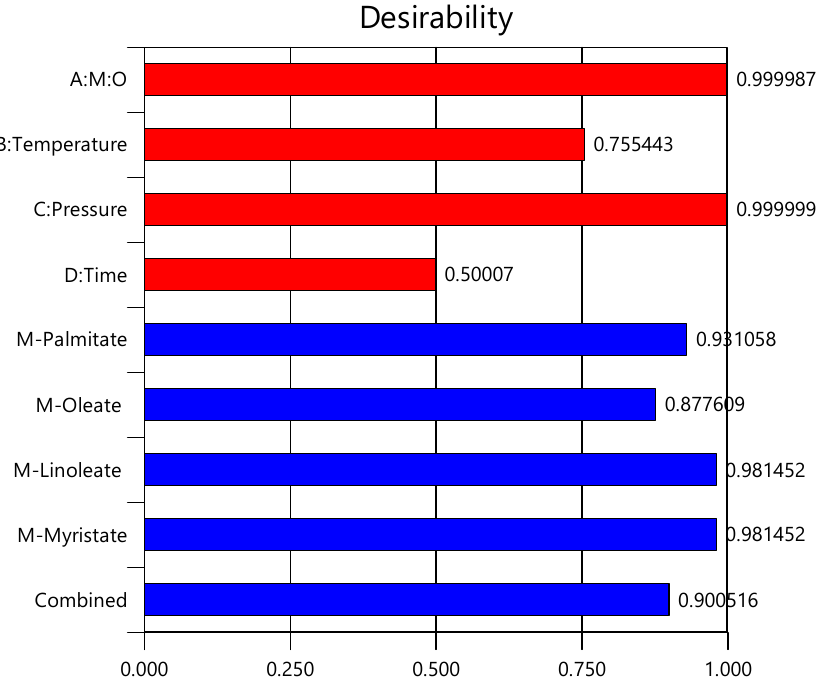
Figure 4. Summary of the achieved individual and combined desirability of the process variables and responses.